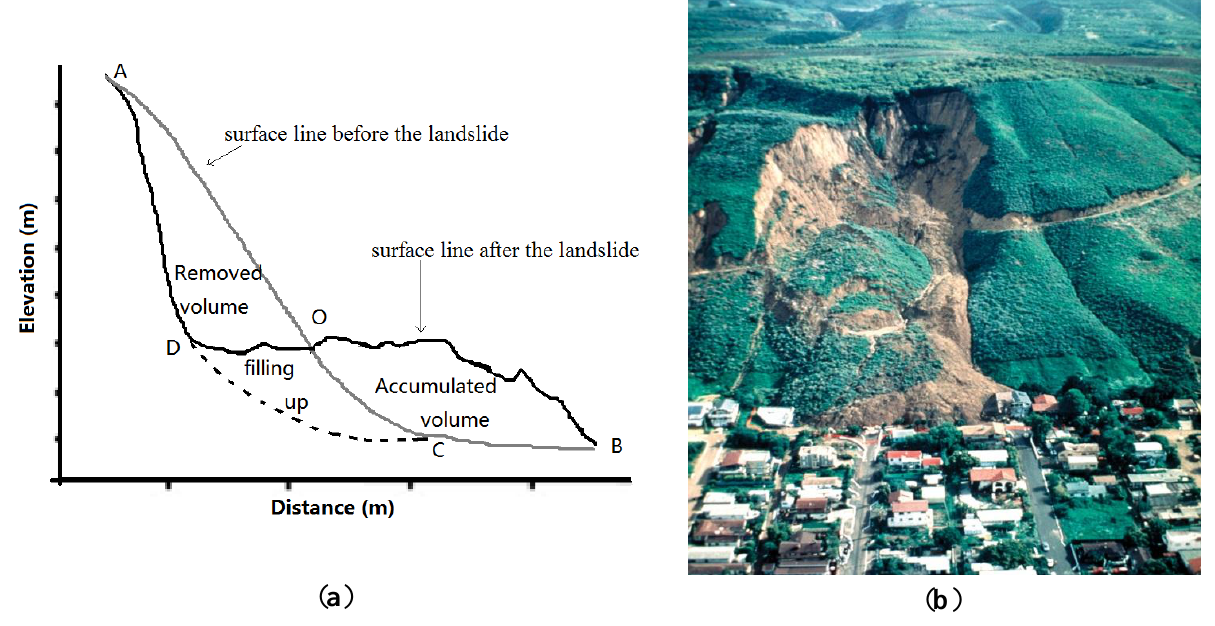
Figure 1. ( a ) Side projection of a typical landslide; ( b ) Photo of the La Conchita Landslide, California, USA, 1996. Photo by R.L. Schuster, US Geological